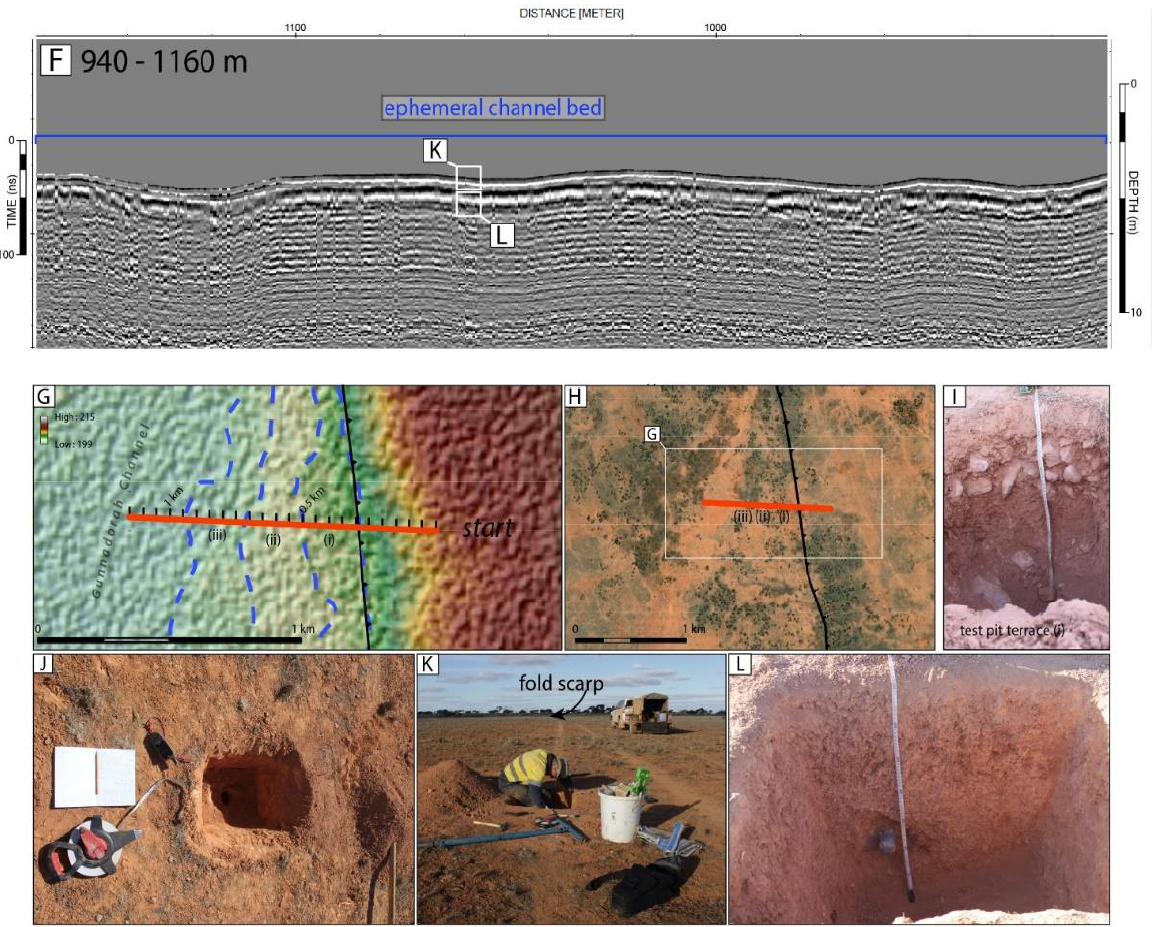
Figure 6. GPR transect N2 across f91 and ponded Gunnadorah Channel, northern Nullarbor. ( A ) shows the full GPR transect with the interpreted main scarp, three terraces (i), (ii), iii) and the Gunnadorah channel bed. ( B – F ) Enlarged GPR panels showing interpreted reflectors in yellow and other identified features marked as follows: (i – iii): degradational terrace risers, (i) = oldest/(iii) youngest; (a): disturbed, however, strong surface reflector package up to ~900 m imaging silty to sandy sediments underlain by nodular to tabular calcrete; (b): airwave diffraction from trees; ( G ) shows the local DEM and location of the GPR transect (red line) with the adjusted colormap indicating the main scarp, the degradational terraces and the channel bed (from E to W); ( H ) Orthophoto showing the GPR transect in relation to the surrounding landscape with the channel bed indicated by the large brown zone in the lefthand third of the image; ( I ) shows the profile in a testpit on terrace (i). A thin, ~10 cm thick, silty to sandy soil profile is underlain by a ~20 cm thick unit of blocky calcrete interbedded with unconsolidated silts and sands. Progressing calcretization below the blocky calcrete is represented by a ~20 cm thick unit of nodular calcrete forming in silts and sands. The bottom of the pit exposes another unit of blocky calcrete. ( J ) Shows a test pit at the edge of the channel bed. A very thin silty to sandy soil profile is underlain by a homogeneous unit off silt and sand deposits interspersed with nodular calcrete. ( K ) shows the location of a test pit within the central channel bed and the fold scarp f91 in the background only indicated by larger vegetation. ( L ) shows the profile of the central channel testpit with a similarly homogenous unit as in (iii). As implied by the depth difference of the pits in ( J ) and ( L ) the sediments in ( L ) are, however, less consolidated.